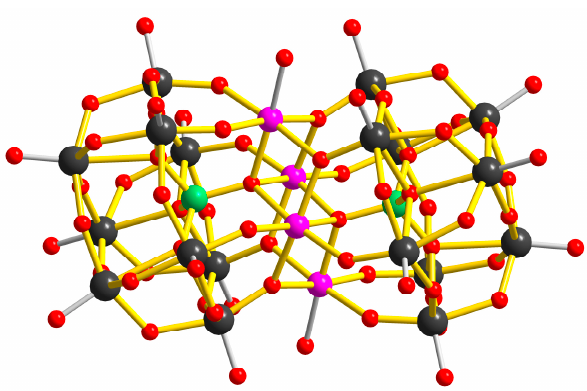
Figure 7. Structure of the anion of the compound 22 . Color scheme: Co, pink; V, green; W, black; O, red; M–O–M bonds are highlighted by yellow.